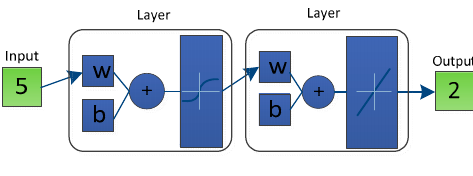
Figure 5. The network structure.